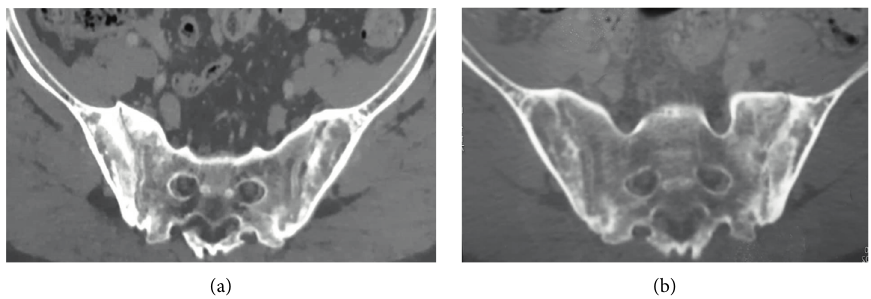
Figure 8: CT scan 12 months later showing ankylosis of the sacroiliac